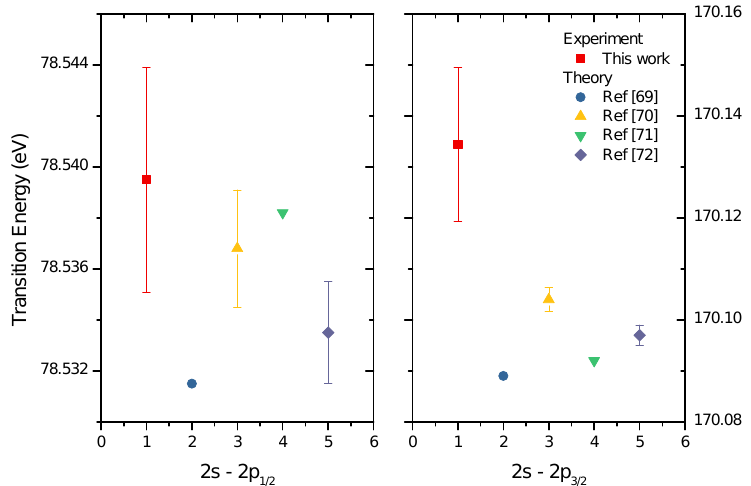
Figure 6. Comparison of measured and calculated Li-like yttrium